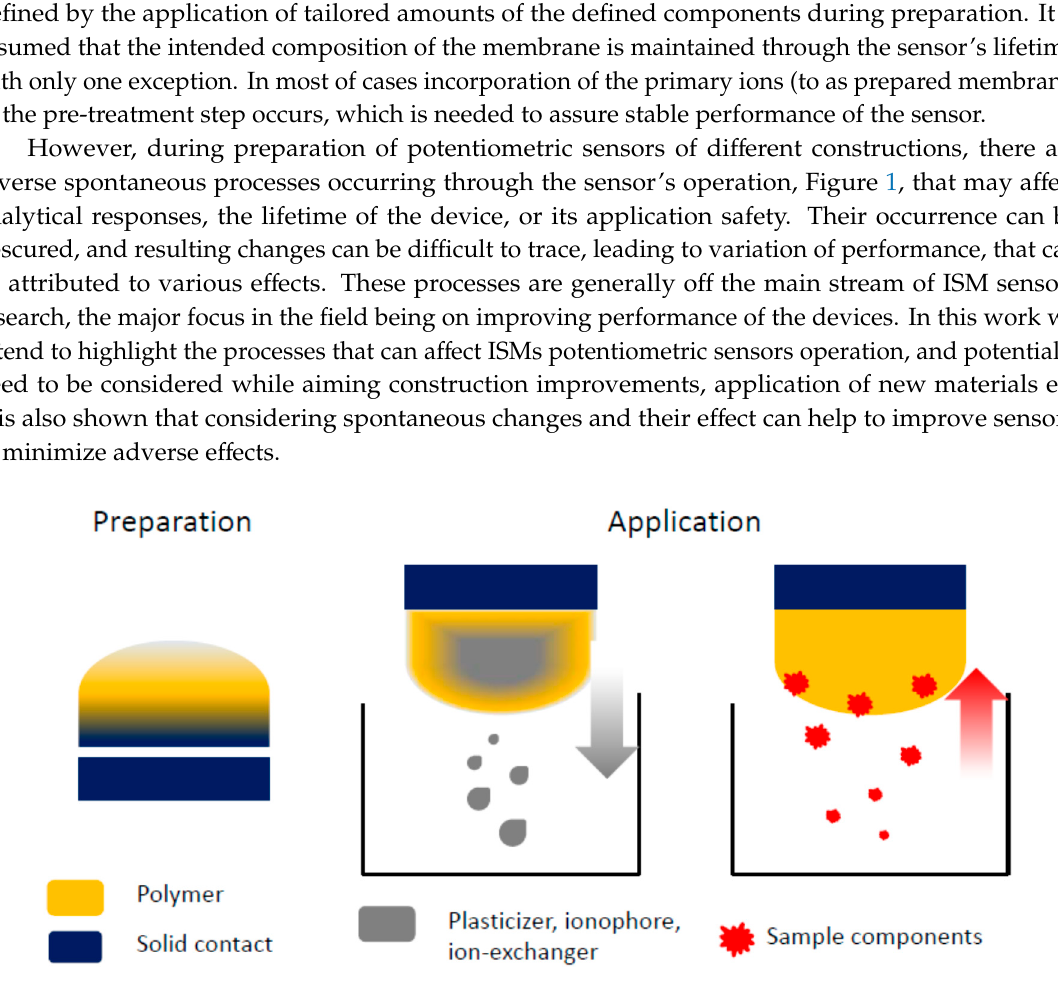
Figure 1. Schematic representation of processes related to ion-selective membrane occurring during sensor preparation as well as application.